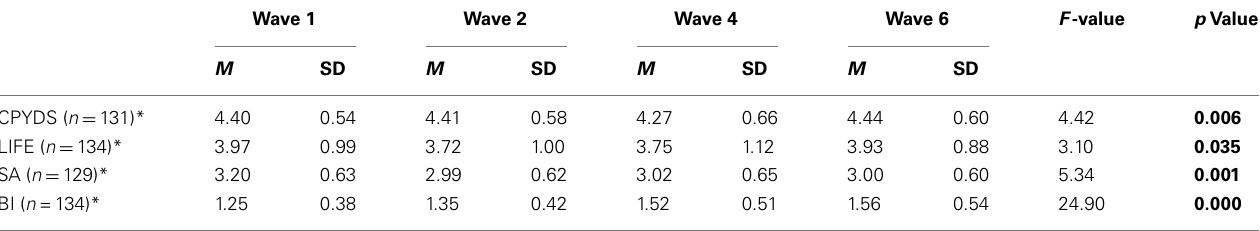
Table 10 |The continuous effect of P.A.T.H.S. based on different scales . Wave